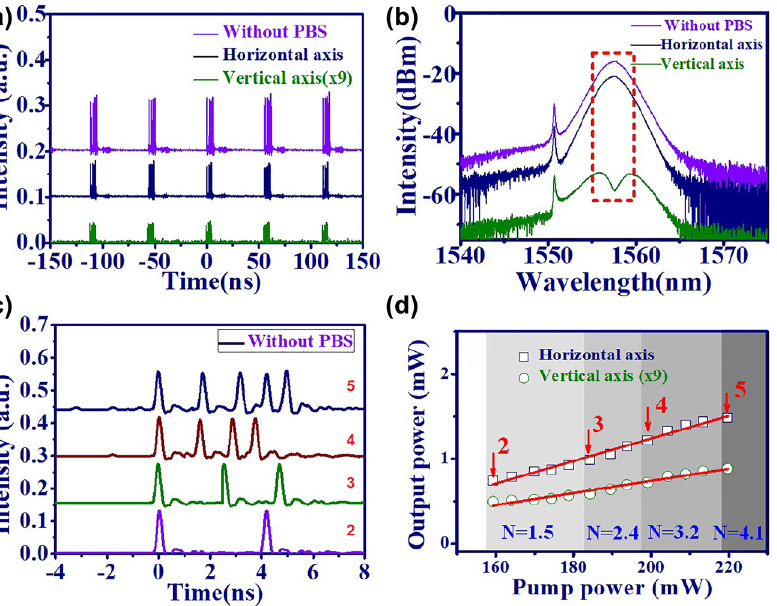
Figure 7: Bunch GVLVSs form PML-EDFL based on GO/PVA film. (a) Time trace and (b) optical spectrum of the quintuple GVLVSs (without PBS: purple line, horizontal axis: navy line and vertical axis: green line). (c) Time trace of different operation state bunch GVLVSs (purple line: the dual, green line: the triple, brown line: the quadruple and navy line: the quintuple vector solitons). (d) Output power of bunch GVLVSs as a function of pump power in operation in different states.